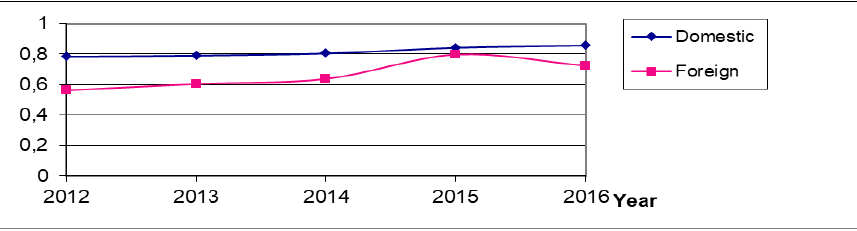
Figure 6: Comparison between domestic banks and foreign banks by using an annual average of asset utilization ratio for year 2012-2016